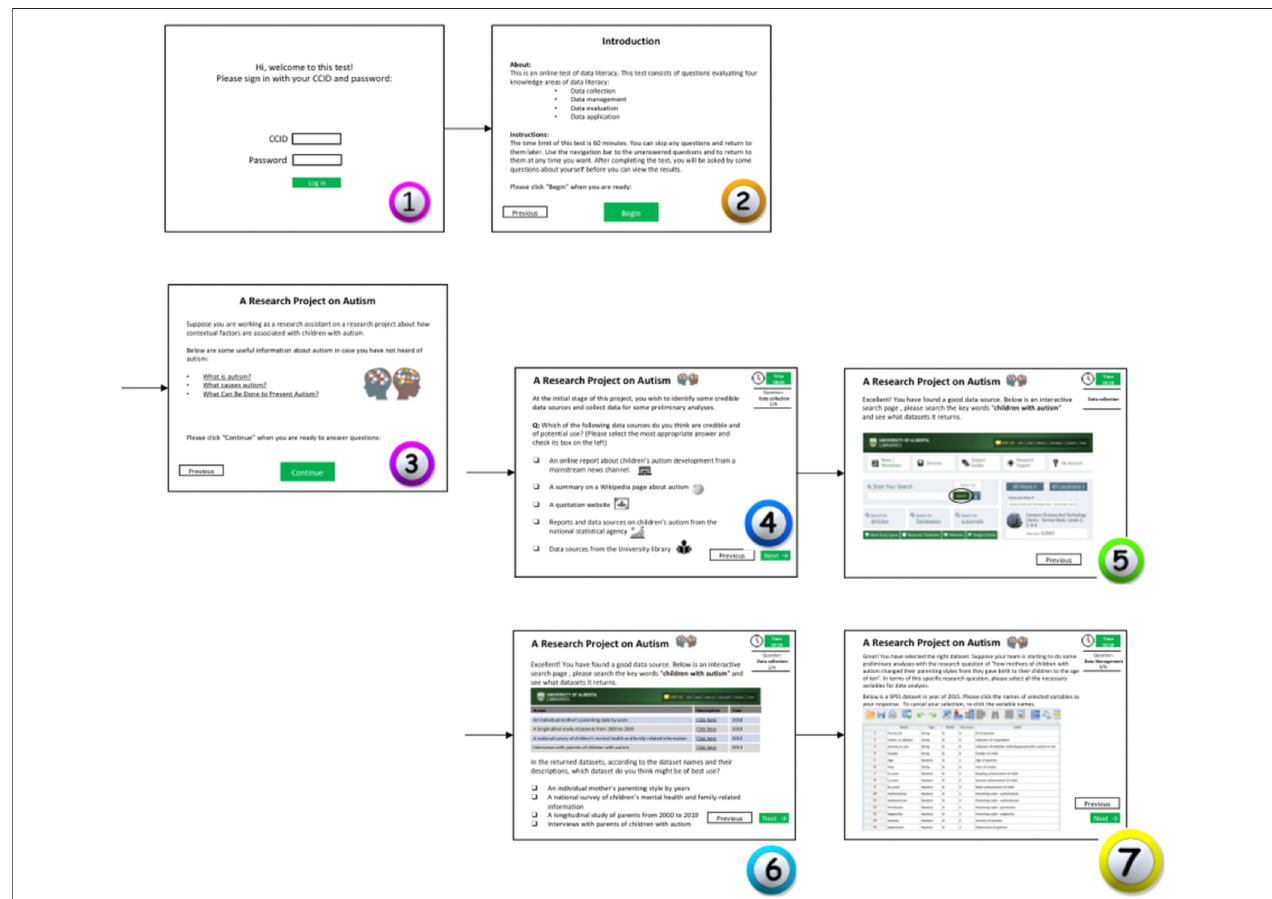
FIGURE 5 | Example of story board to illustrate the design of a digital teaching and assessment module of critical thinking in the area of autism.